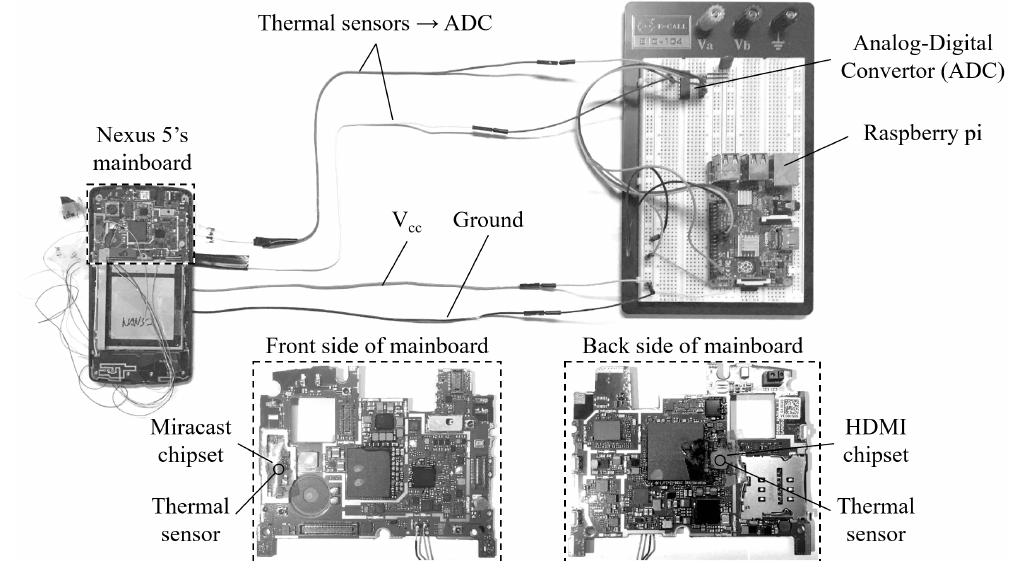
Figure 7. The experimental configuration for offline thermal model